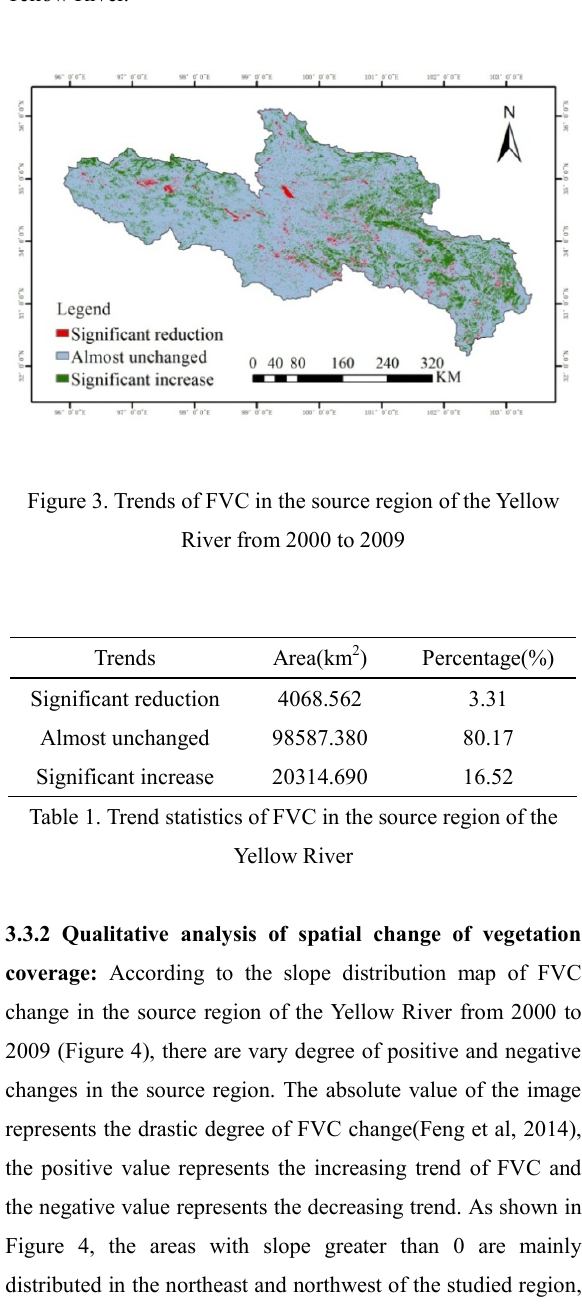
distributed in the northeast and northwest of the studied region,